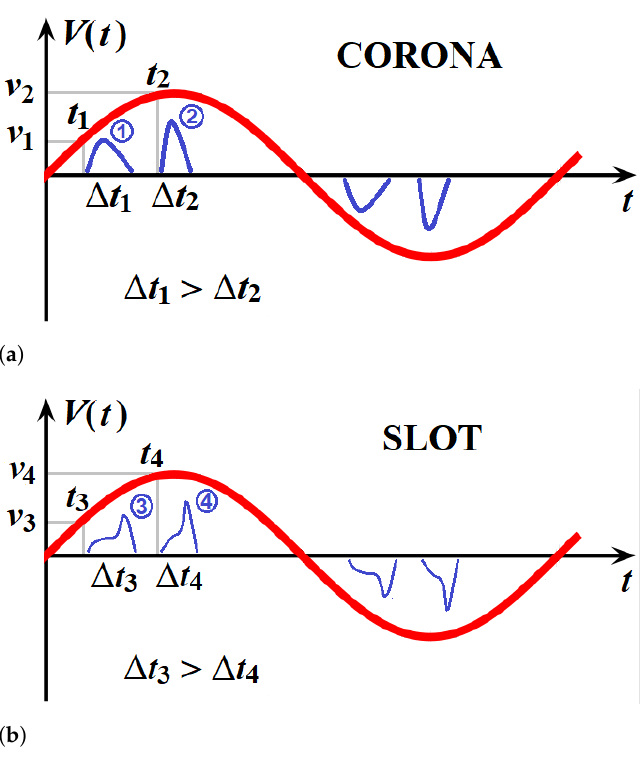
Figure 3. Ilustrations of partial discharges in a sinusoidal voltage signal: ( a ) corona and ( b )